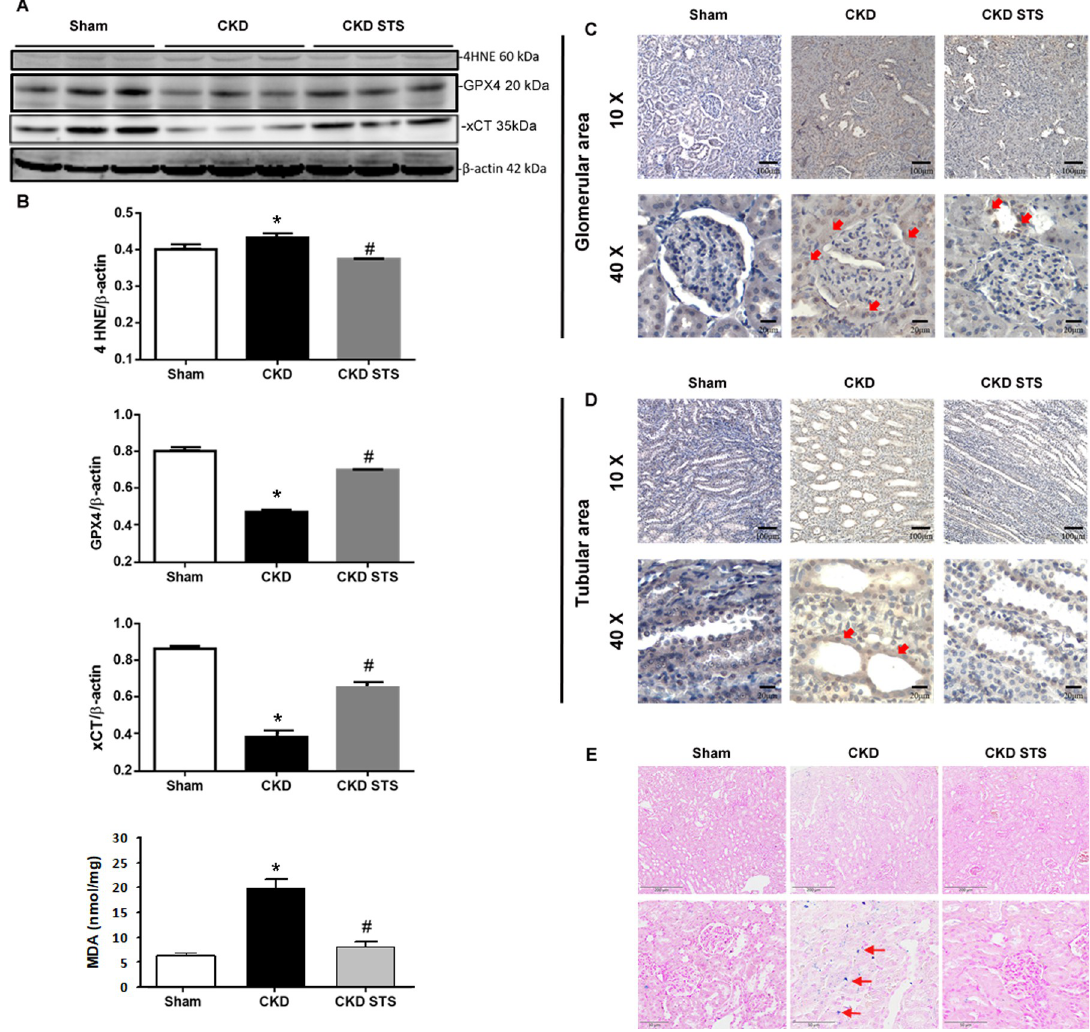
Fig 6. Western blot of 4-HNE, GPX4 and xCT expression and MDA assay in CKD induced kidney injury (A, B). Immunohistochemistry of brown 4-HNE expression (red arrows) is indicated in the glomerular and tubular areas of the CKD and CKD STS kidneys (C, D). Prussian blue stain for iron-overloaded ferroptosis is indicated in E (red arrows). Data are expressed as mean ± SEM (n = 3). � P < 0.05 vs. Sham. # P < 0.05 vs.